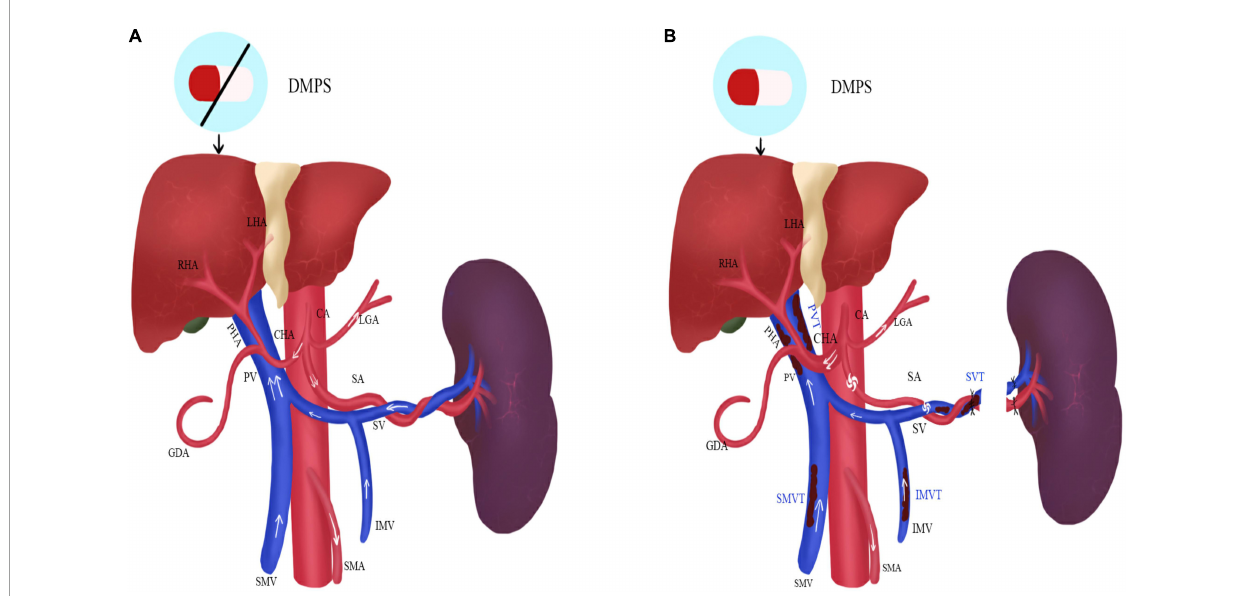
FIGURE1 The status of the portal vein system thrombosis before and after operation in HLD patients. (A) Before operation; (B) after operation; DMPS, 2,3-Dimercaptopropanesulfonic Sodium; LHA, left hepatic artery; RHA, right hepatic artery; PHA, proper hepatic artery; CHA, common hepatic artery; GDA, gastroduodenal artery; CA, celiac artery; LGA, left gastric artery; SA, splenic artery; SMA, superior mesenteric artery; PV, portal vein; SMV, superior mesenteric vein; IMV, inferior mesenteric vein; PVT, portal venous thrombosis; SVT, splenic vein thrombosis; SMVT, superior mesenteric vein thrombosis; IMVT, inferior mesenteric vein